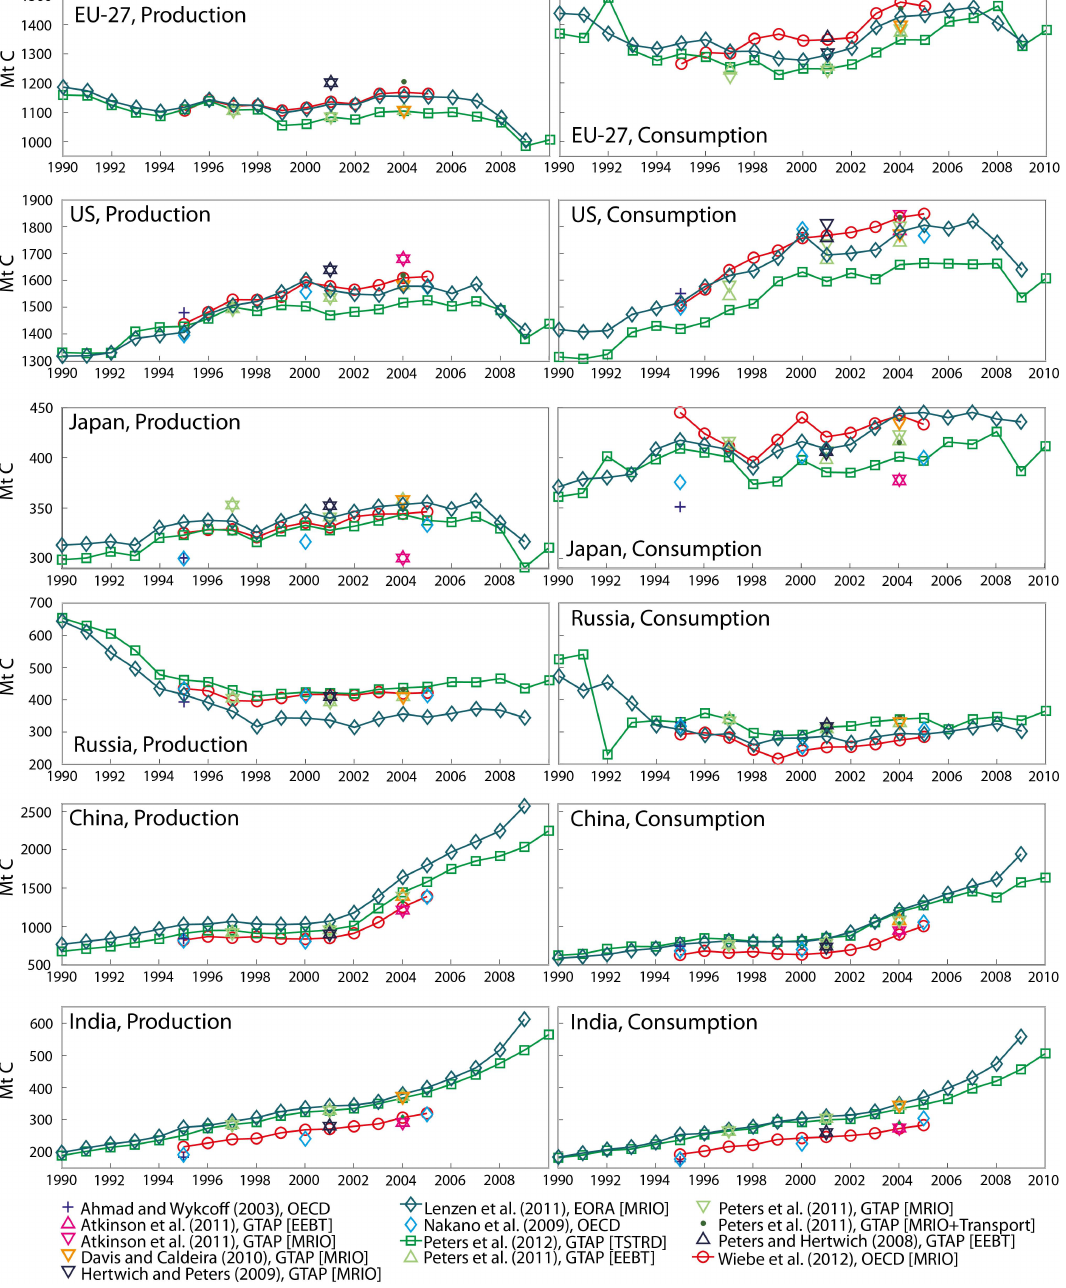
Fig. 1. Comparisons of global models of CO 2 emissions embodied in traded goods and services. Each country has the same scale for production and consumption. The minimum value has not been taken as zero to highlight the differences, but relative to national totals, the differences are smaller (cf., Tables 3 and 5). Although there is some variation among studies due to differences in the underlying data and modelling methods, the patterns and trends are broadly consistent among all the studies